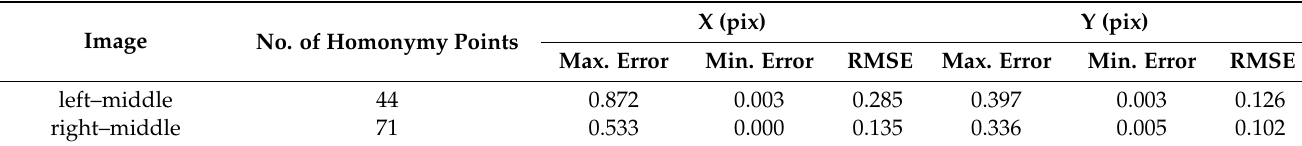
Table 11. Stitching error of EA-unstable-1